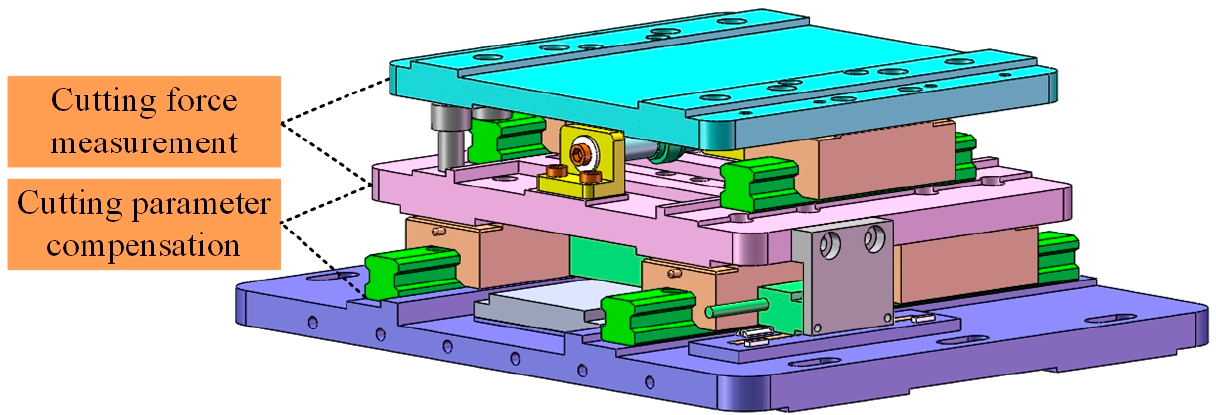
Figure 2. The designed cutting force measurement and cutting parameter compensation device.